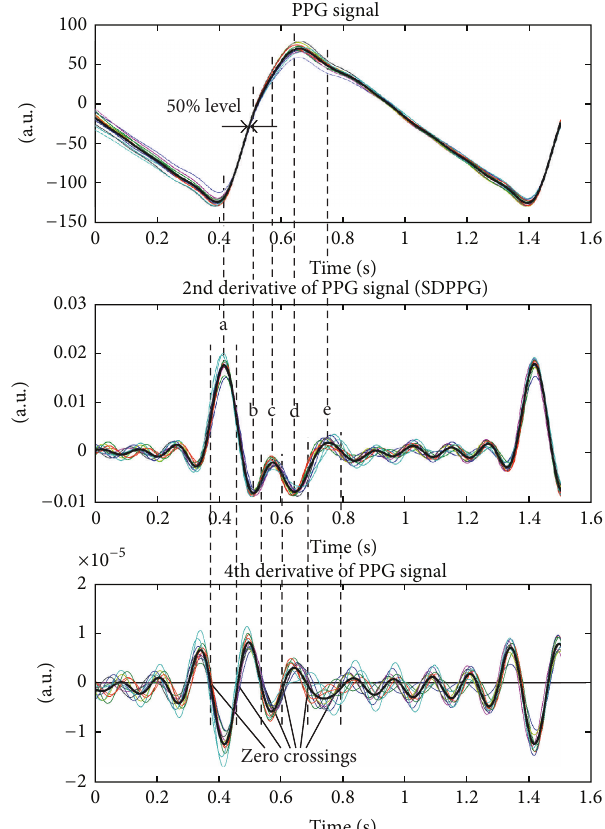
Figure 4: The averaged PPG and its second derivative and fourth derivative waveforms (black bold line) with filtered and normalized recurrences (thin lines). The recurrences are aligned according to 50% of the PPG signal raising front and the distinct waves “a”, “b”, “c”, “d”, and “e” are detected by using the zero crossings of the fourth